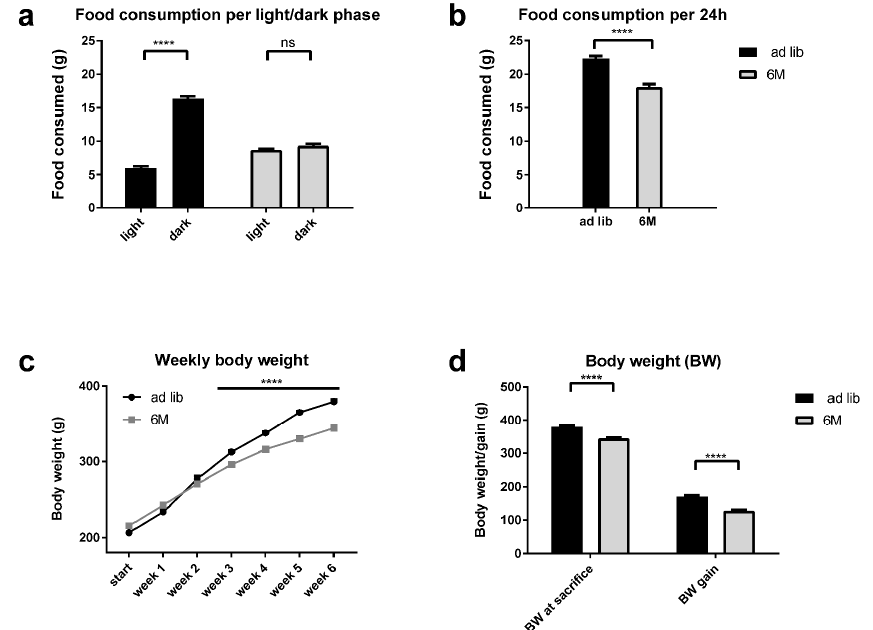
Figure 1. Analysis of the daily food intake and body weight of the subset of animals that have been inside the metabolic cages. ( a ) Difference in daily food intake between light and dark phase for the ad libitum and 6M fed animals, i.e., asterisks and ns refer to light/dark differences within the ad libitum and 6M group. ( b ) Average 24 h food intake for both groups of animals. ( c ) Growth curve for both groups of animals, animals were weighed on a weekly basis after start of the experiment. ( d ) Body weight at time of sacrifice ( left ) and absolute body weight gain during the experiment ( right ) for both groups of animals. Data are depicted as means ± SEM. ns = non-significant, **** p < 0.0001, n = 15–16 per group. ad lib = ad libitum fed animals (black lines and bars), 6M = animals fed according to the 6 meals a day feeding regimen (grey lines and